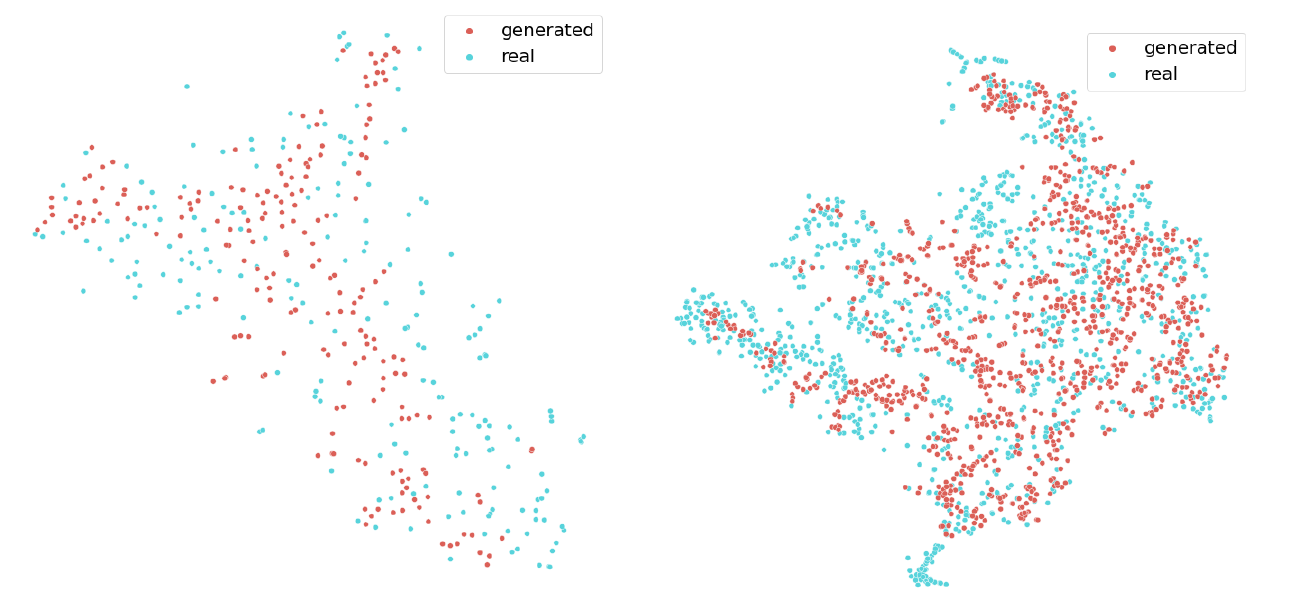
Figure 7. The two figures show the results from the t-sne. The red points are the generated points, and the blue points are the real data